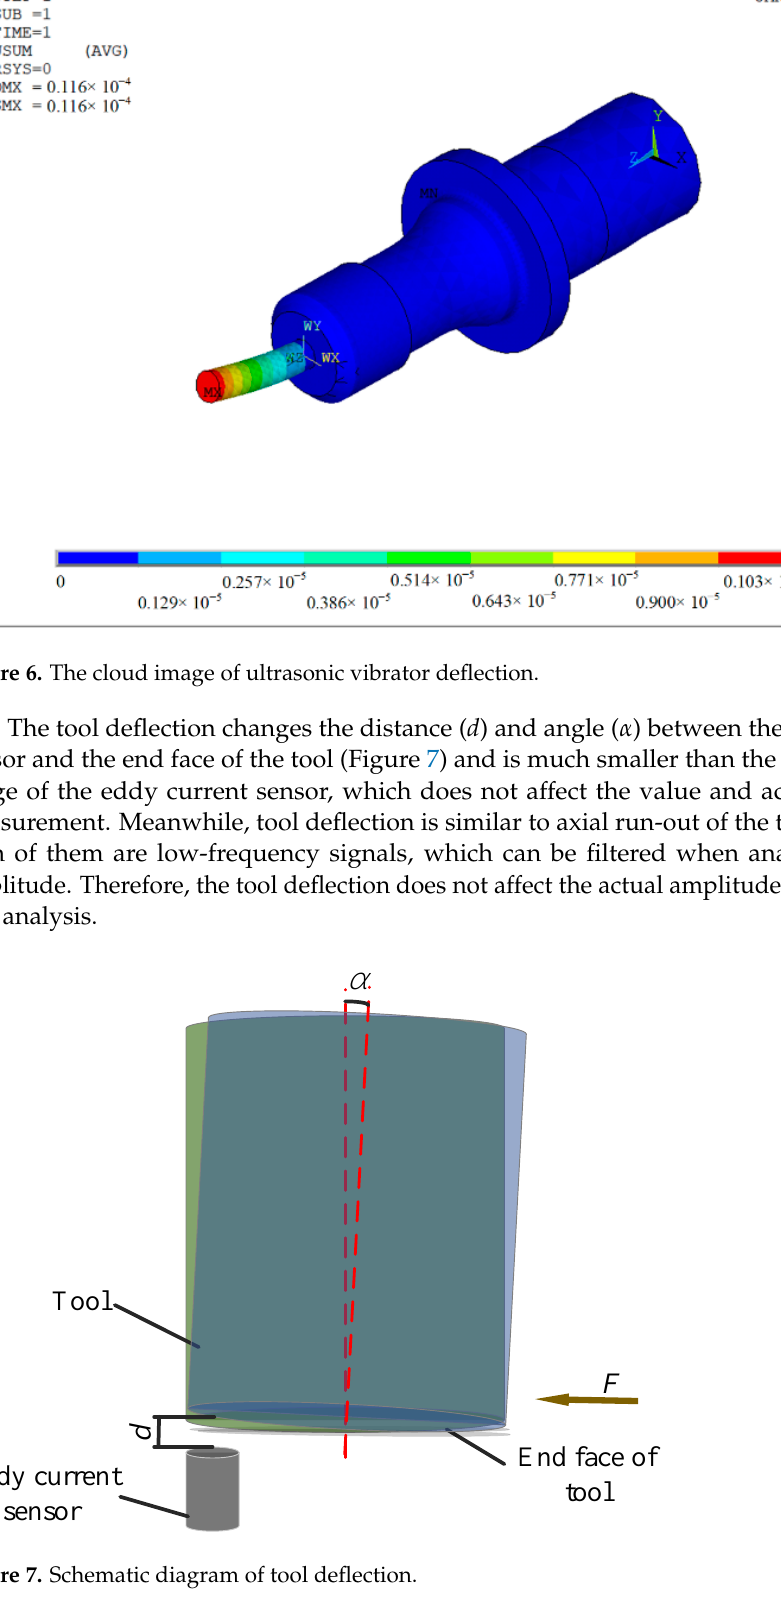
Figure 7. Schematic diagram of tool deflection.